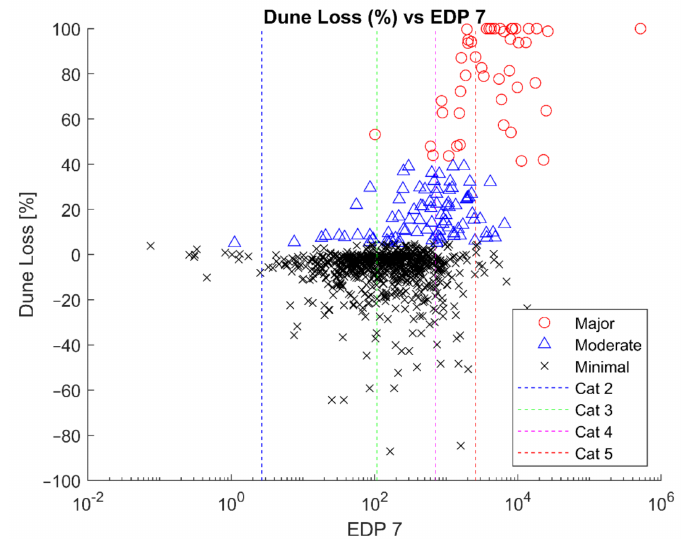
Figure 6. Observed dune loss percentage as a function of EDP Case 7; each data point represents observations from a single profile. X-axis is the EDP. Storm categories are denoted by colored vertical dashed lines. Storm category PEI values converted to an EDP using median resilience parameters. The Y-axis is dune loss percentage. Red circles indicate Major loss (>40%), blue circles indicate Moderate (>5% but <40%). Negative dune loss indicates